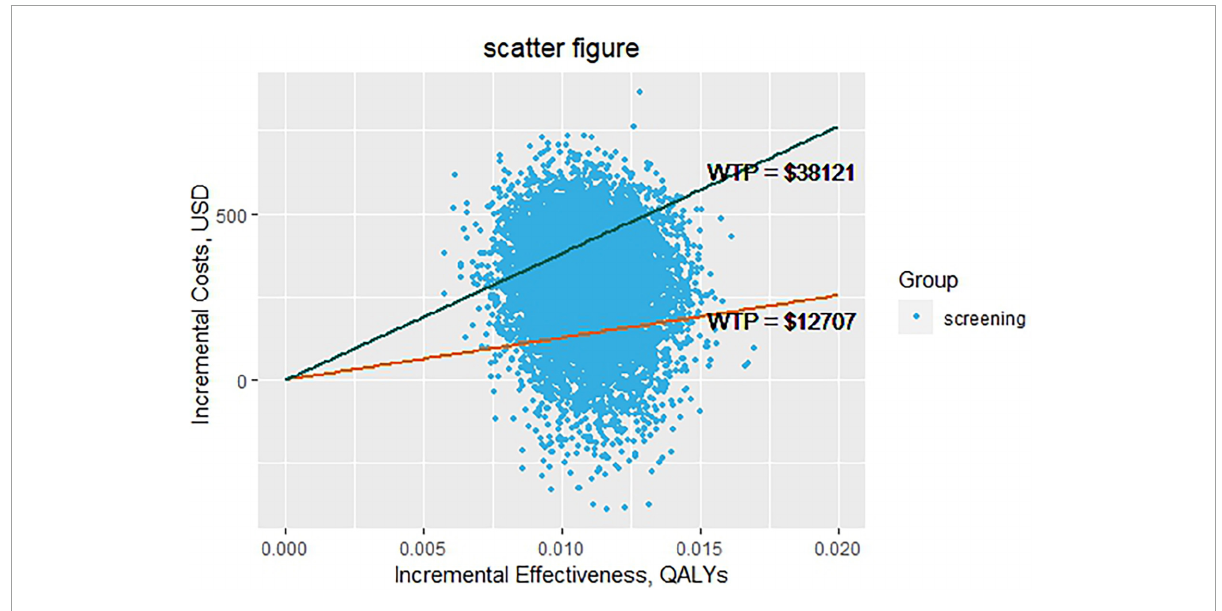
FIGURE3 Probabilistic sensitivity